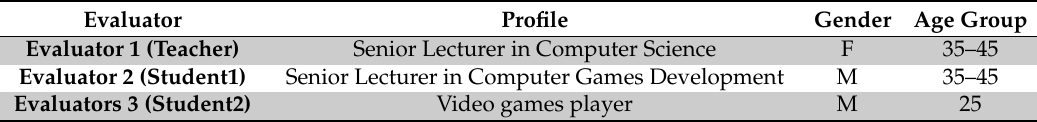
Table 2. The profiles of the three